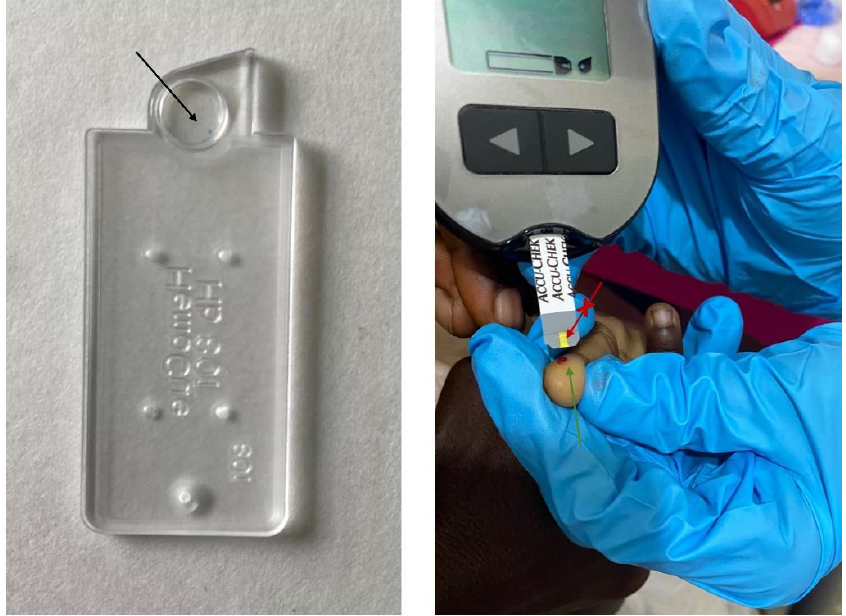
Figure 5. Pictures illustrating the blue dot observed in the microcuvettes of the hemoglobinometer (black arrow) and application of blood to the front edge (green arrow) and not on the top (red arrow) of the glucometer strip.